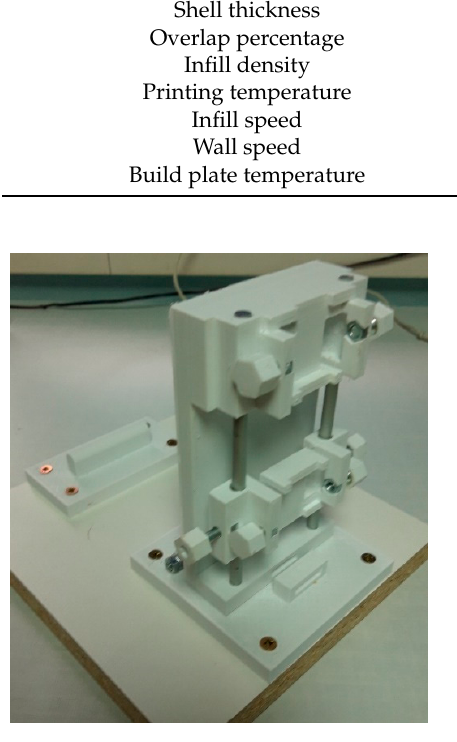
Figure 6. Physical model of the calibrator.